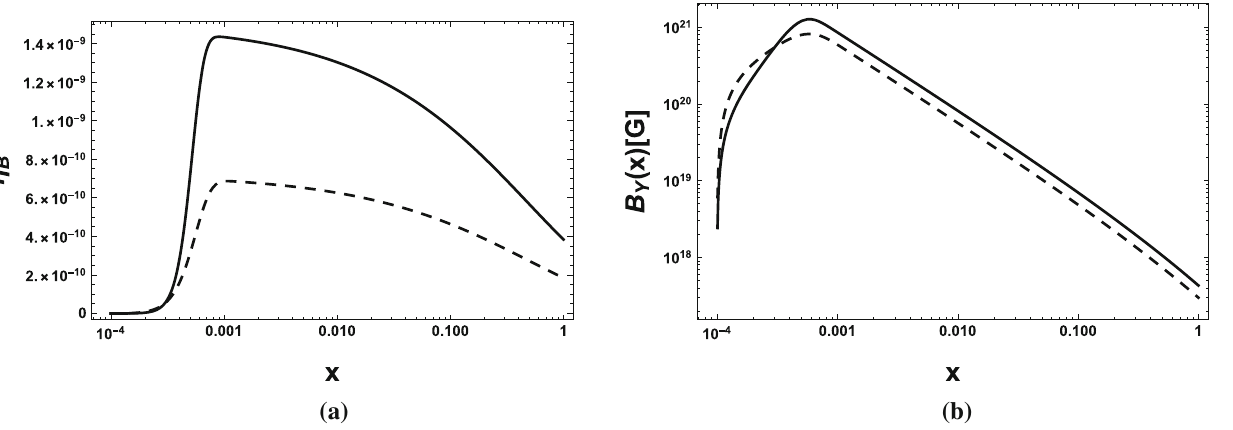
= 5 × 10 − 4 , b = 2 × 10 − 4 , and x β 0 is for vorticity fluctuation with v 0 = 10 − 5 , and the dashed line is for ( 0 ) = 0, η ( 0 ) = η ( 0 ) = η ( 0 ) = 0, constant vorticity with v 0 = 10 − e R e L Y B